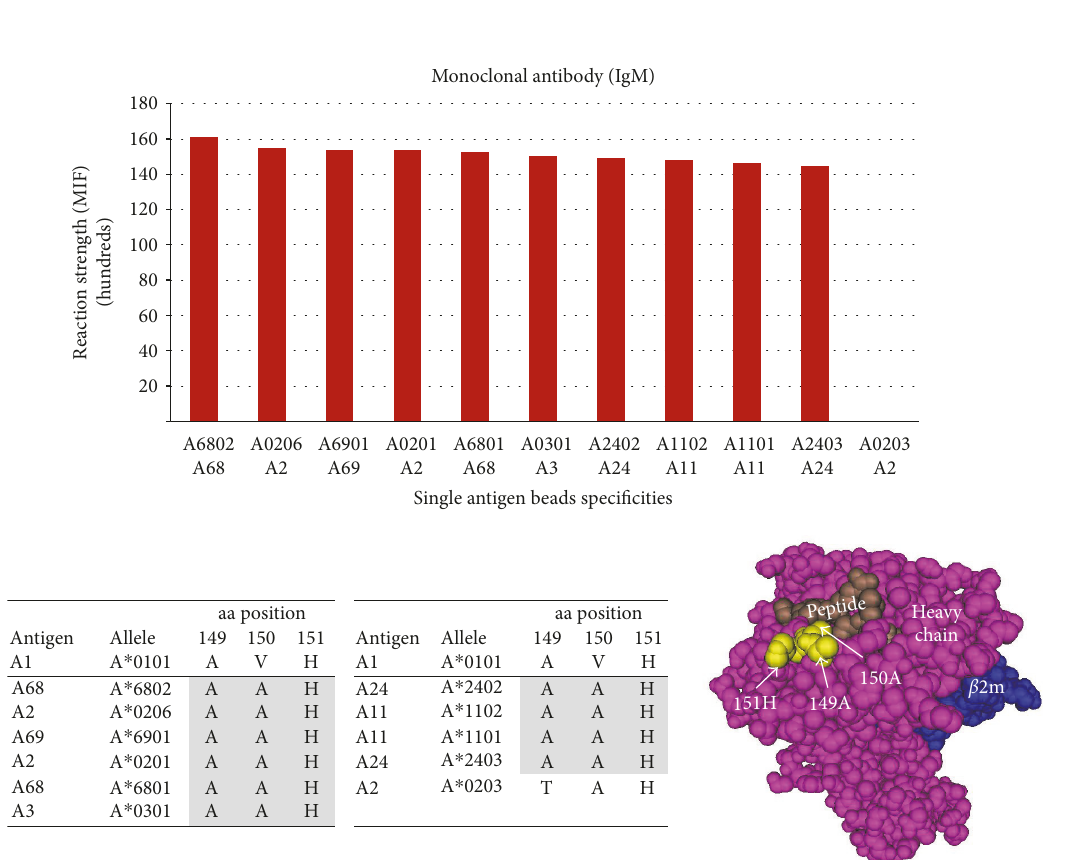
Figure 5: Epitope 422 shared by A-locus antigens A2, A3, A11, A24, A68, and A69 de fi ned by the aa acid combination 149A +150A +151H. One amino acid substitution at position 149 (aa T substituted for aa a) could be the reason that A2 allele A ∗ 0203 is negative while alleles HLA A ∗ 0201 and A ∗ 0206 are